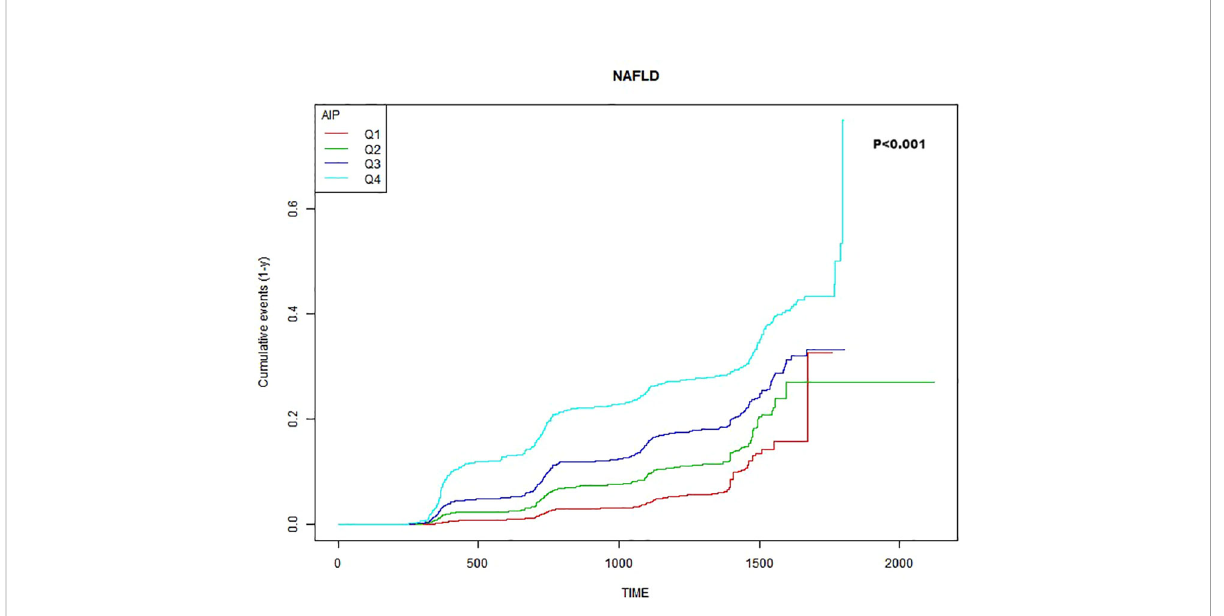
FIGURE 1 Kaplan – Meier estimation of new-onset NAFLD by AIP quartiles.